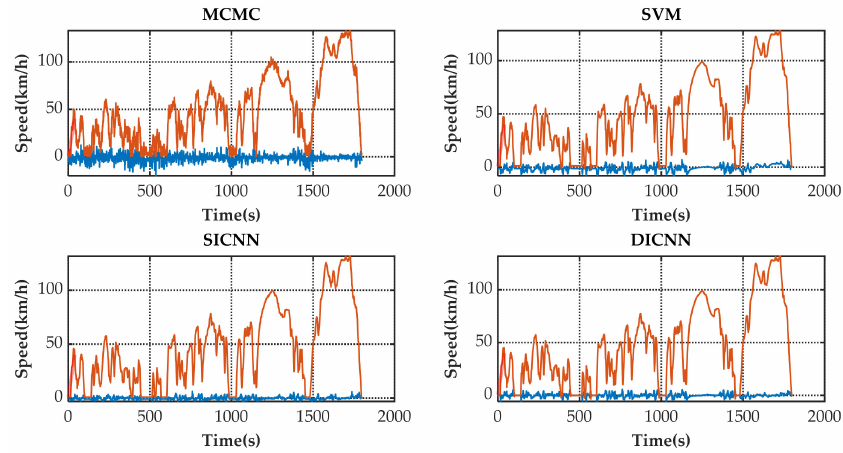
Figure 10. The prediction error (blue) and prediction speed (orange) for the next 1 s.